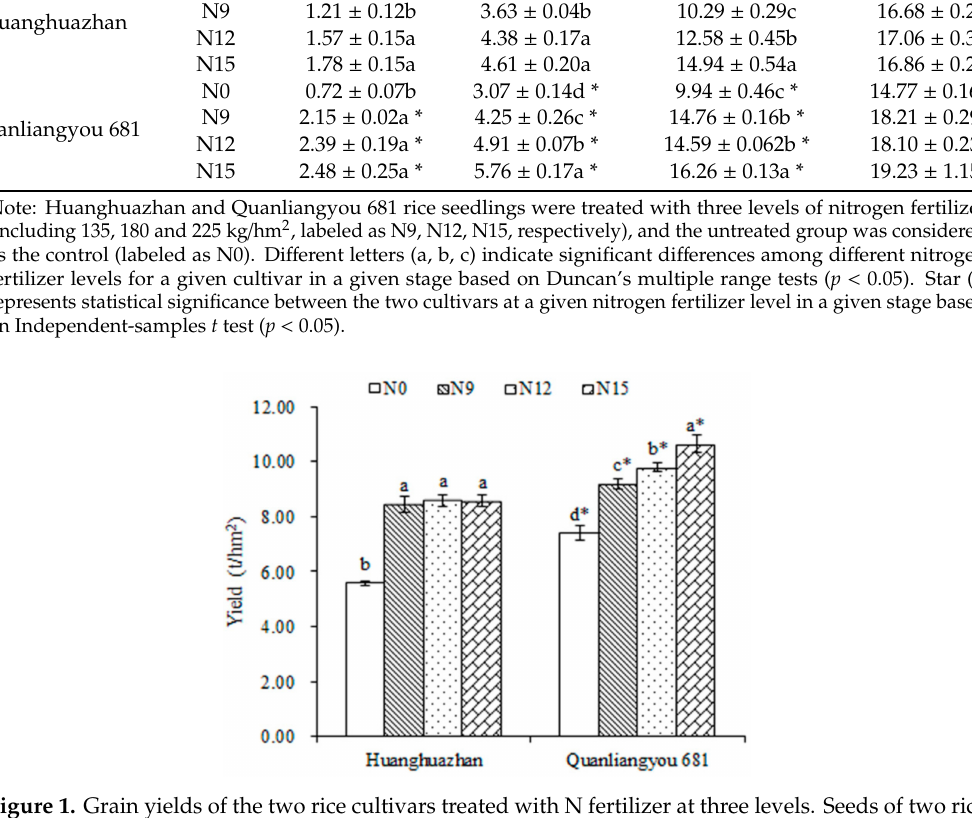
Figure 1. Grain yields of the two rice cultivars treated with N fertilizer at three levels. Seeds of two rice varieties, conventional rice Huanghuazhan and indica hybrid rice Quanliangyou 681, were soaked, pre-germinated for 48 h, and sown in soil. Seedlings of the two rice varieties were treated with nitrogen fertilizer at three levels (including 135, 180 and 225 kg / hm 2 , labeled as N9, N12, N15, respectively), and the untreated group was considered as the control (labeled as N0). Di ff erent letters (a, b, c) indicate significant di ff erences among di ff erent nitrogen fertilizer levels for a given cultivar based on Duncan’s multiple range tests ( p < 0.05). Star (*) represents statistical significance between the two cultivars at a given nitrogen fertilizer level based on Independent-samples t test ( p <